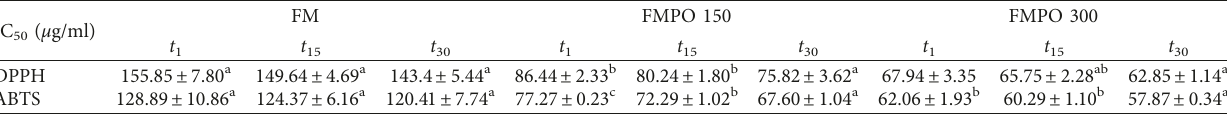
Table 3: Radical-scavenging activity (DPPH and ABTS) of FMPO 150, FMPO 300, and FM during storage. IC 50 ( μ g/ml)